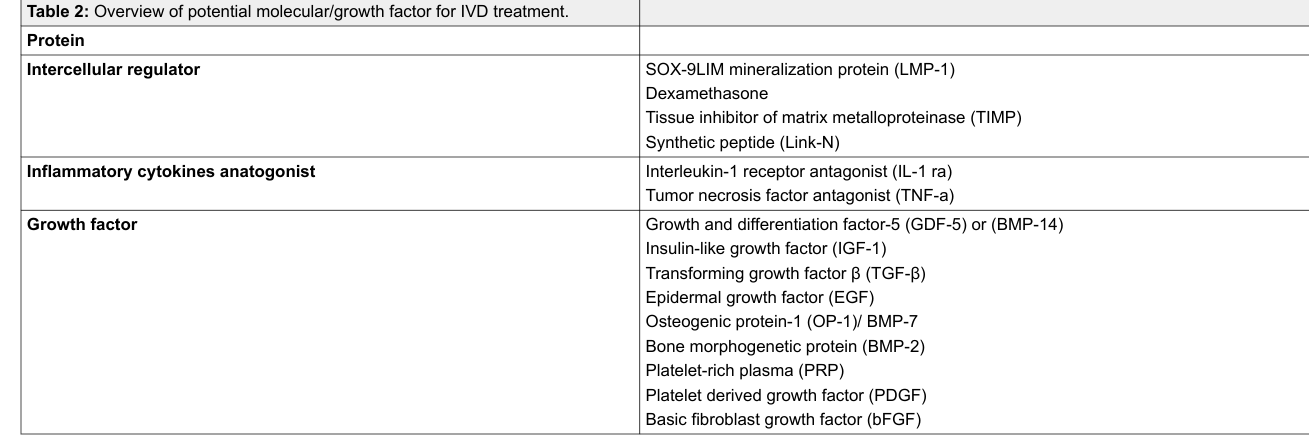
Table 2: Overview of potential molecular/growth factor for IVD treatment. Protein Intercellular regulator SOX-9LIM mineralization protein (LMP-1)